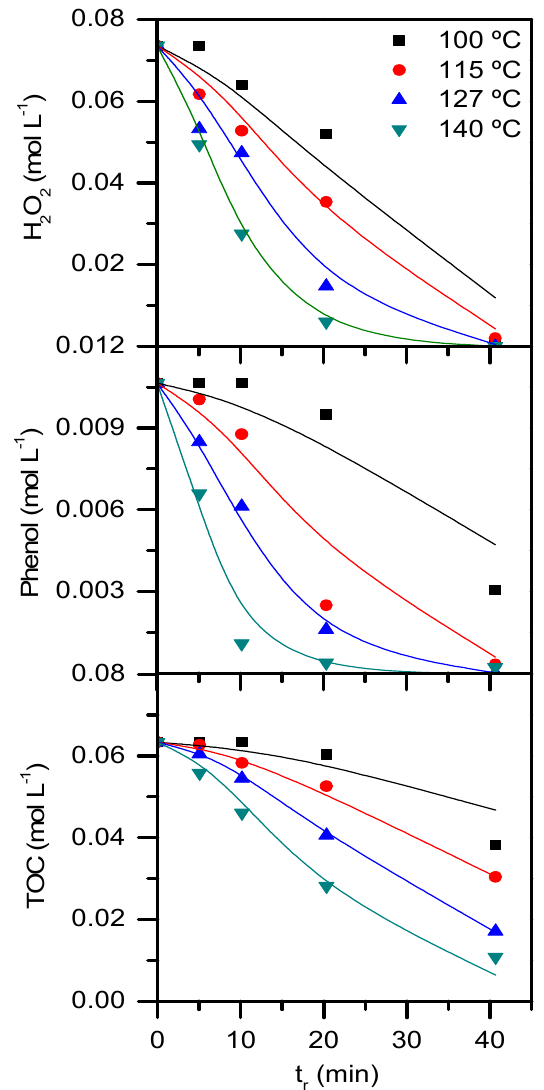
Figure 6. Experimental (symbols) and predicted (lines) concentrations of H 2 O 2, phenol and TOC by the autocatalytic kinetic model of the phenol WPO-O 2 over quartz beads at different temperatures. Operating conditions: [Phenol] 0 = 1000 mg L − 1 , [H 2 O 2 ] 0 = 2500 mg L − 1 , P O2 = 8 bar, natural pH 0 and W quartz = 29 g.